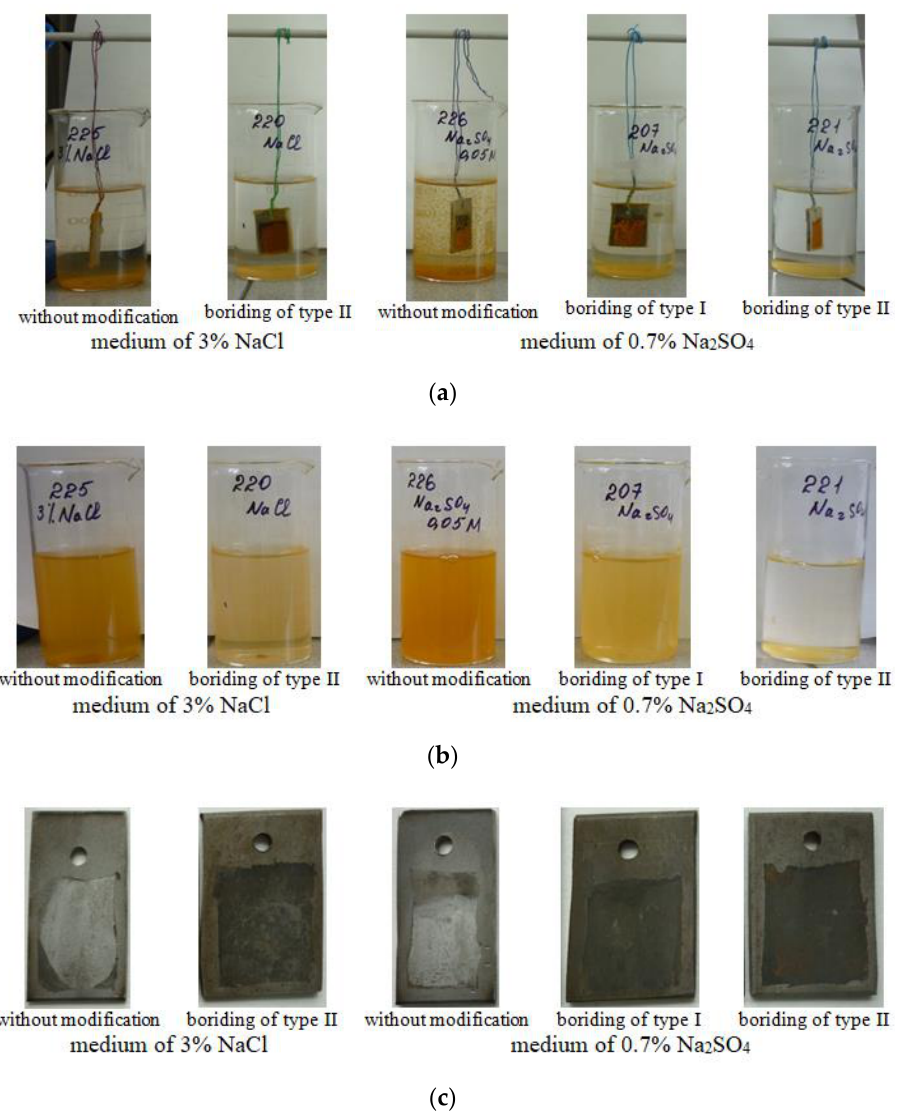
Figure 5. Pictures of samples during corrosion tests by the gravimetric method in media of 3% NaCl solution and 0.7% Na 2 SO 4 solution, exposure time of 10 days: ( a ) placement of samples in vessels; ( b ) colour of solutions after tests; ( c ) appearance of samples after removal of deposits. With an increasing thickness of the boride layer, the transfer of iron ions into the solution (change in colour of solutions) decreases (Figure 5b). The appearance of the samples after the removal of deposits is shown in Figure 5c. The corrosion properties of the samples are shown in Table 3. Table 3. Corrosion properties of samples.